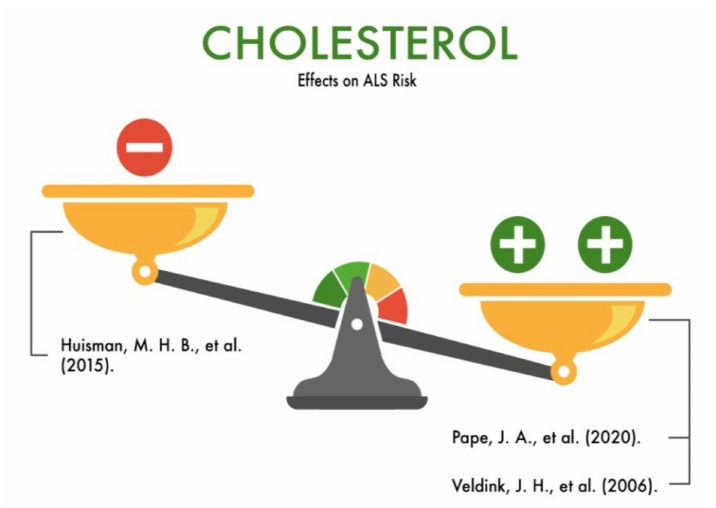
Figure 11. The effect of cholesterol on the risk of developing amyotrophic lateral sclerosis